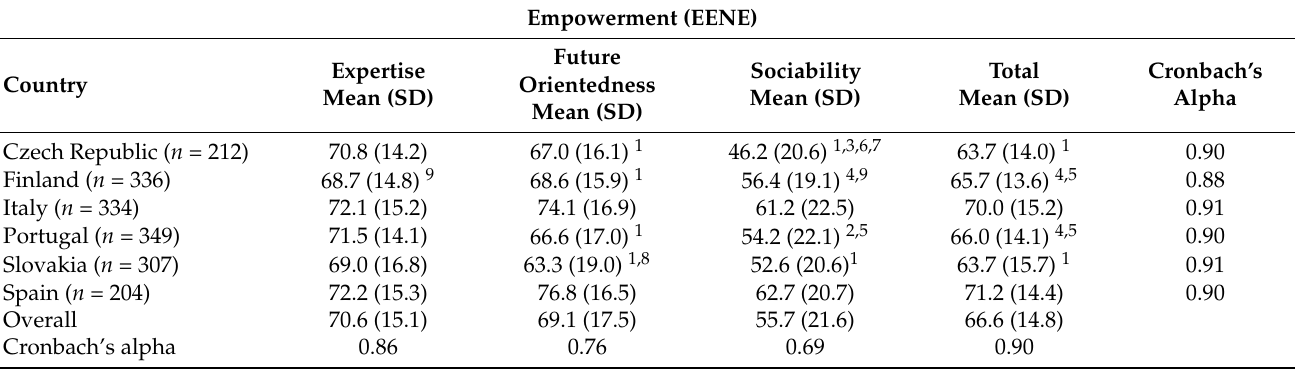
Table 1. GNSs’ level of empowerment analyzed with one-way ANOVA, pairwise comparison corrected with Tukey’s method ( n = 1742).